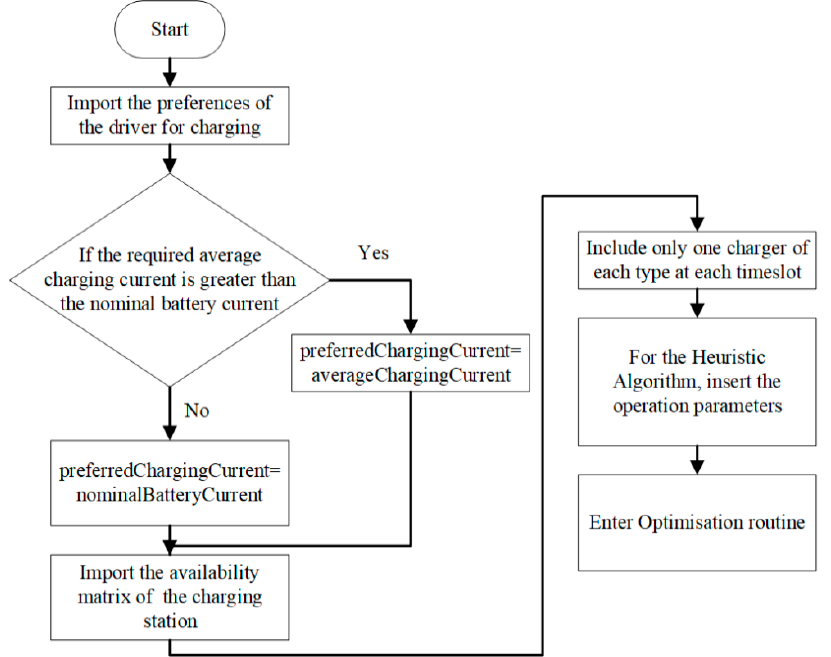
Figure 3. The flowchart to import the variables for the initialisation of the optimisation.